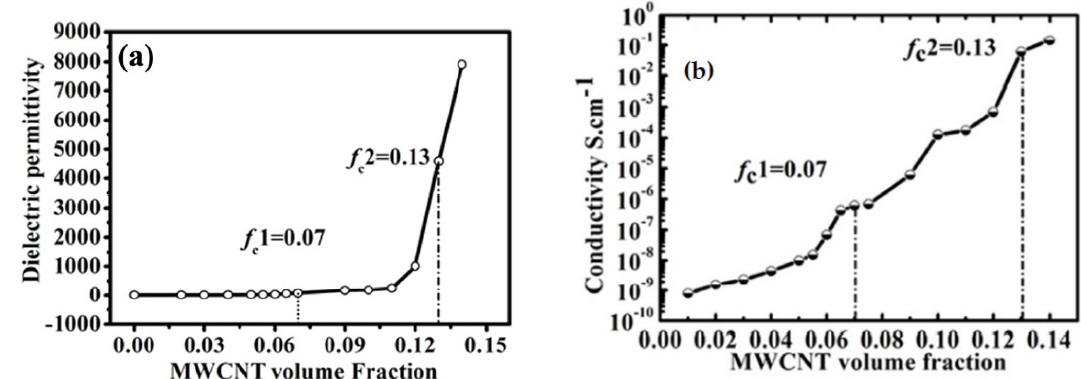
Figure 2. The percolation effect on the dielectric constant [23].( a ) Dielectric Permittivity; ( b ) electricalconductivity of CNT/elastomer composites as a function of CNT loadings.